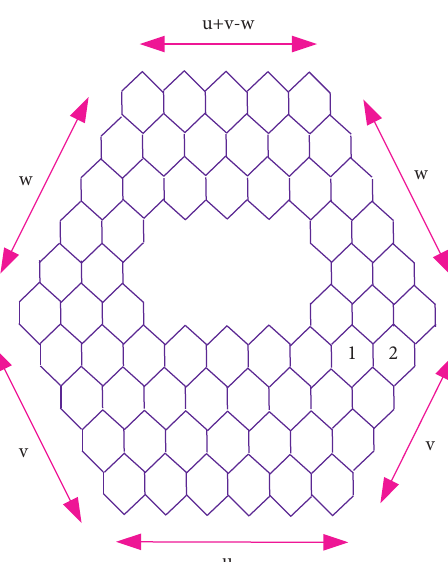
Figure 2: Coronoid system of C